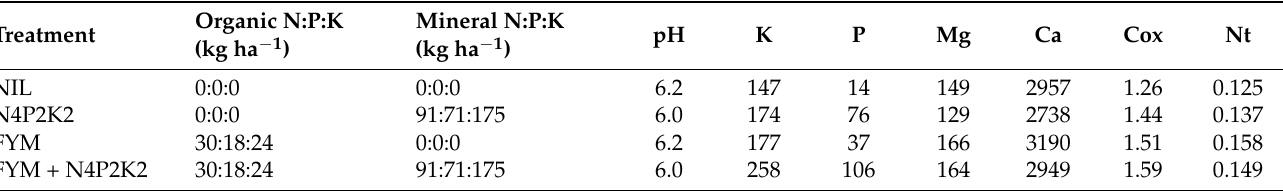
Table 1. Average annual rates of nitrogen (N), phosphorus (P 2 O 5 ) and potassium (K 2 O) for mineral and farmyard manure (FYM) fertilization treatments, mean values of soil pH H 2 O, K, P, Mg and Ca nutrient status (in mg kg − 1 ) together with soil organic carbon (Cox, %) and total soil nitrogen (Nt, %) assessed in 2014. Plant available nutrient concentrations were determined by Mehlich III extraction